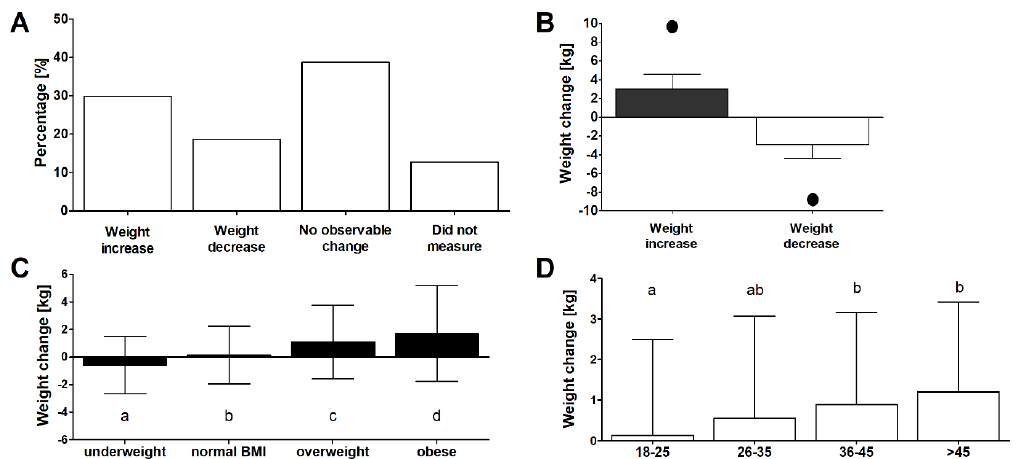
Figure 1. ( A ) Reported trends in weight change during COVID-19 lockdown in the surveyed group ( n = 1097). ( B ) Mean ± SD of experienced weight increase or decrease (black dot represents the maximum value of change reported in the surveyed group). ( C ) Weight change in di ff erent BMI groups. ( D ) Weight change in di ff erent age groups. Di ff erent lowercase letters denote significant di ff erences between groups (Dunn’s test after Kruskal–Wallis analysis of variance (ANOVA), p < 0.05).